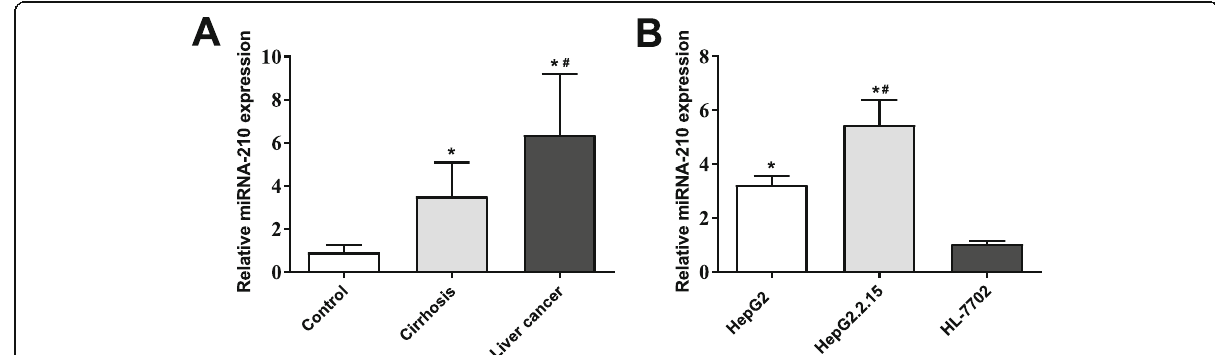
Fig. 1 MiRNA-210 was overexpressed in HBV-associated cirrhosis and liver cancer. a The expression of miRNA-210 was significantly increased in liver tissues of the Cirrhosis and Liver cancer group. * P < 0.05 compared with the Control group. # P < 0.05 compared with the Cirrhosis group. b The expression of miRNA-210 expression was significantly increased in HepG2 and HepG2.2.15 cells. * P < 0.05 compared with HL-7702 cells. # P <